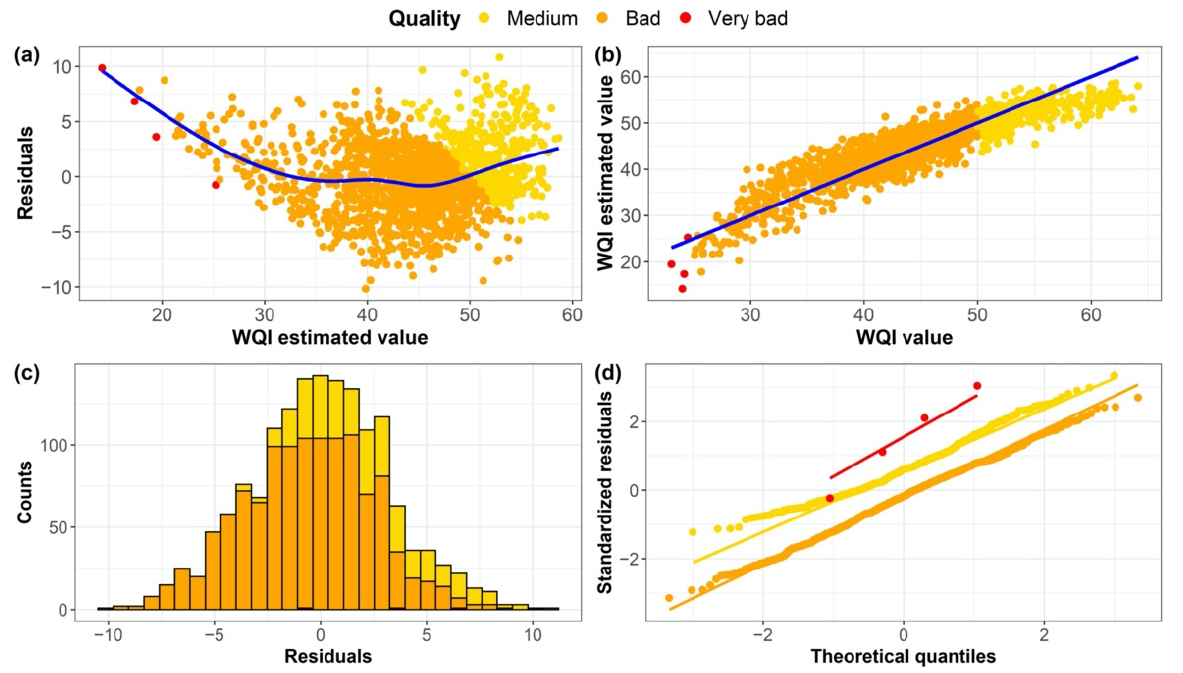
Figure 7. ( a ) Model residuals ( b ) fitted values for the multiple linear regression using the 17 parameters within the training data set, ( c ) histogram of the residuals, and ( d ) QQPlot of standardized